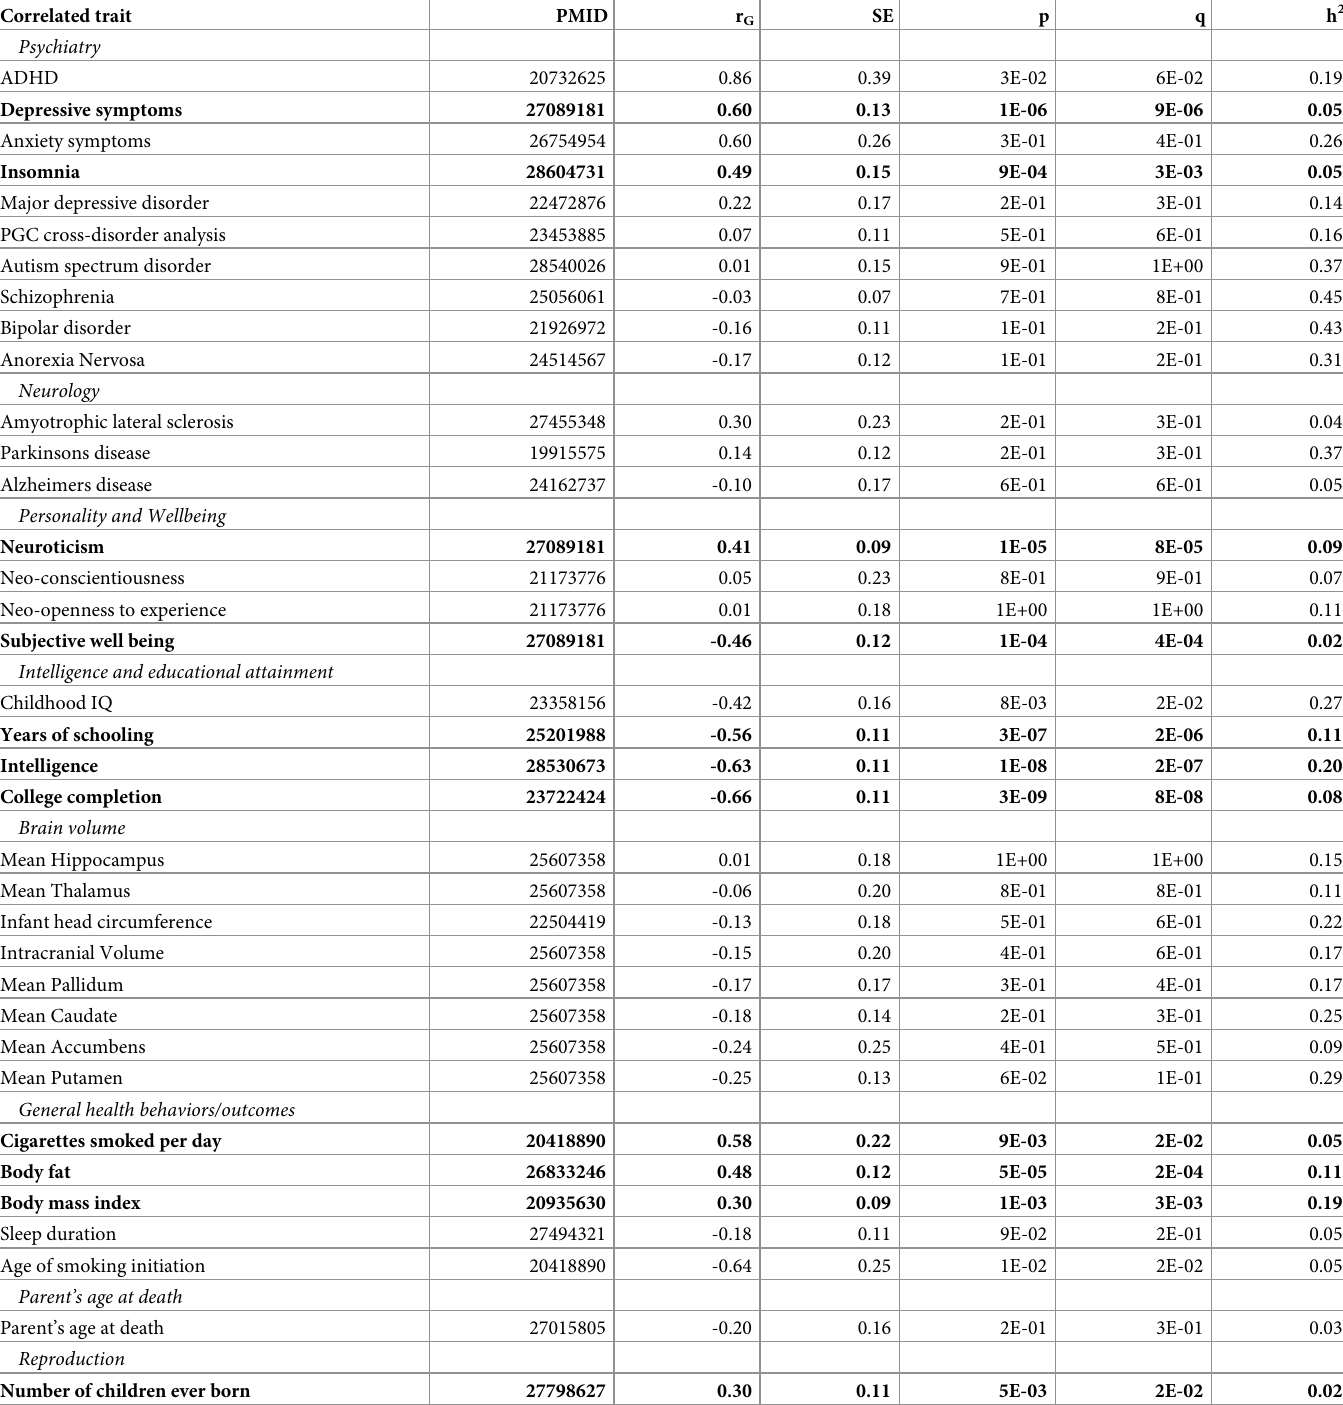
Table 3. Genetic correlations based on LD score